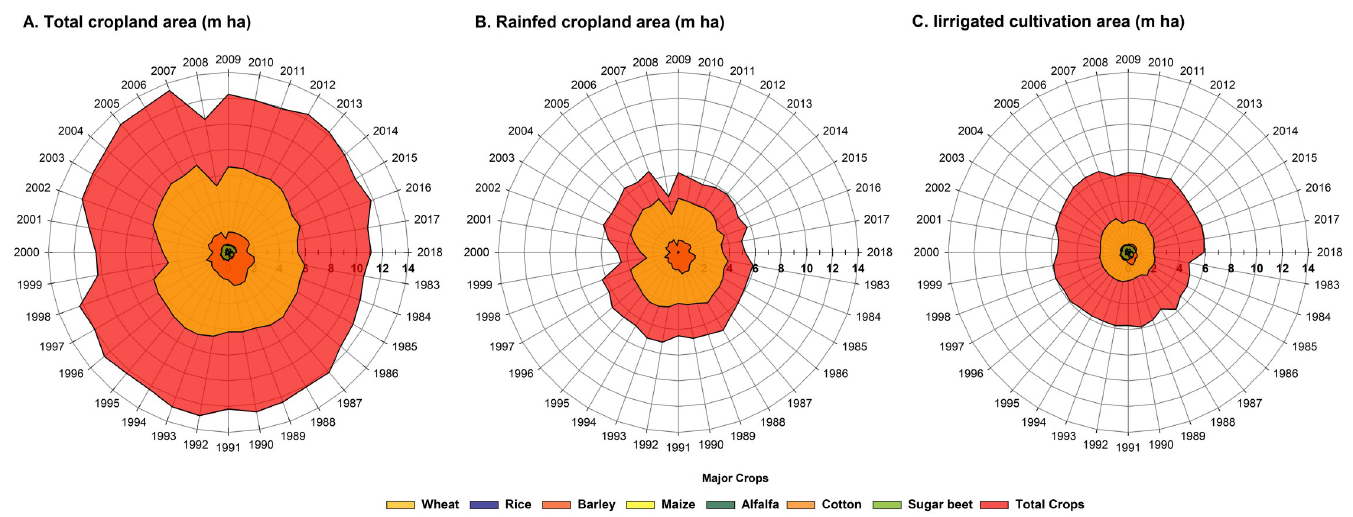
Fig 2. Area of 7 major crops and other crops and vegetables in total (A), rainfed (B) and irrigated (C) cropland in Iran between 1983 and 2018.